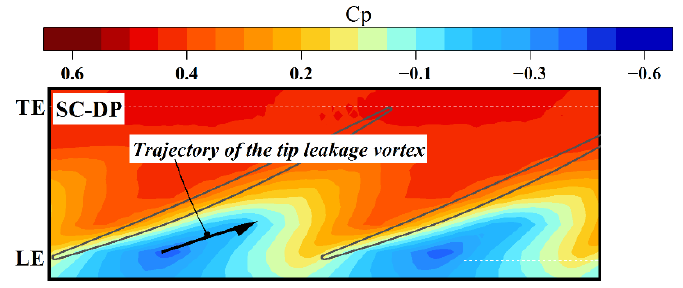
Figure 13. Tip flow structures of the compressor at DP.